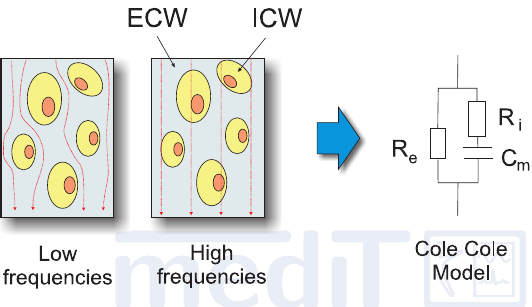
Fig.2: Current flow in tissue and electrical equivalent